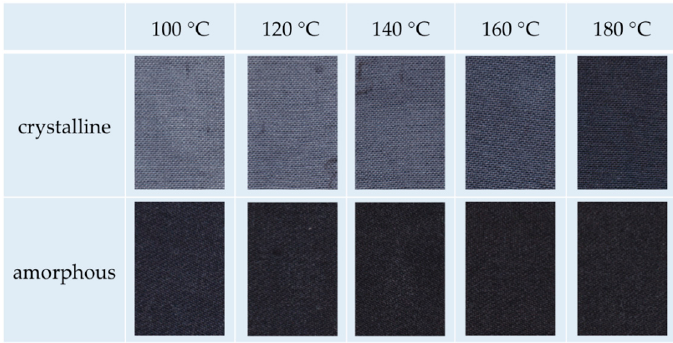
Figure 6. Temperature-dependent dyeing of amorphous and crystalline m-aramid fabrics with Nigrosin in EMIM-EtSO 4 .